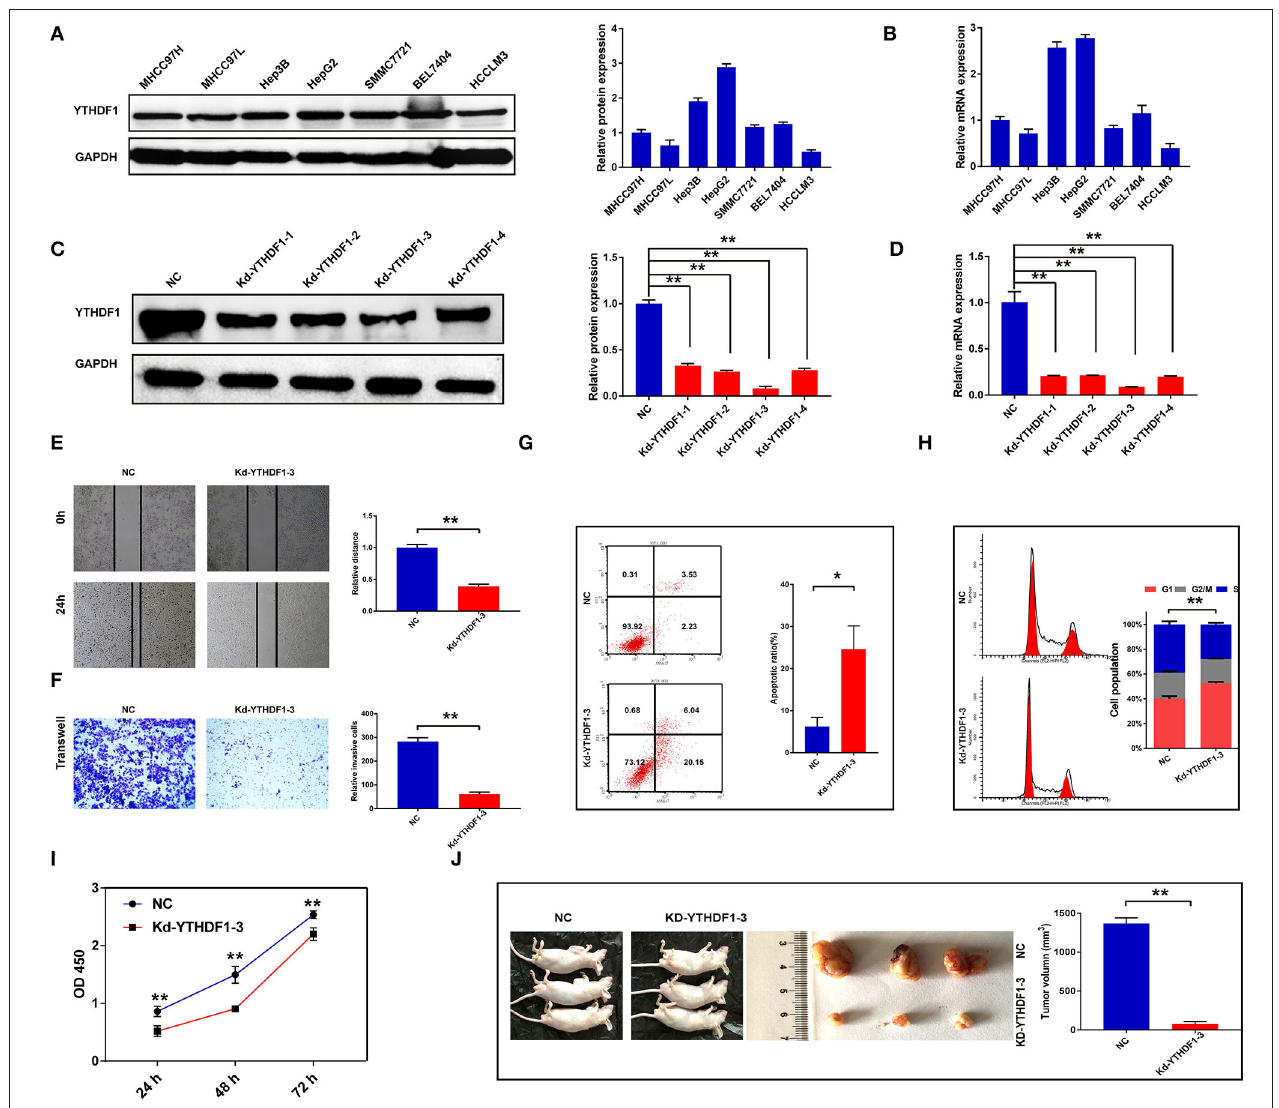
FIGURE 5 | Silencing YTHDF1 inhibited the aggressive behaviors of hepatocellular carcinoma (HCC) cells. (A) The expression of YTHDF1 in HCC cell lines was detected by Western blotting. (B) The mRNA level of YTHDF1 in HCC cell lines was detected by qRT-PCR. (C) Short hairpin RNAs (shRNAs) were transfected into HepG2 cells to block the YTHDF1 expression. The expression of YTHDF1 in each group was detected by Western blotting. (D) The mRNA expression of YTHDF1 in each group was detected by qRT-PCR. (E,F) Migration and invasion of HepG2 cells were detected by wound-healing assay and Transwell assay. (G) The apoptosis of HepG2 cells with YTHDF1 silencing. (H) Cell cycle of HepG2 cells was evaluated by flow cytometry. (I) The proliferation of cells was detected by Cell Counting Kit-8 (CCK-8). (J) The effects of YTHDF1 on tumor growth were evaluated by xenograft tumor in nude mice. * P < 0.05, ** P <